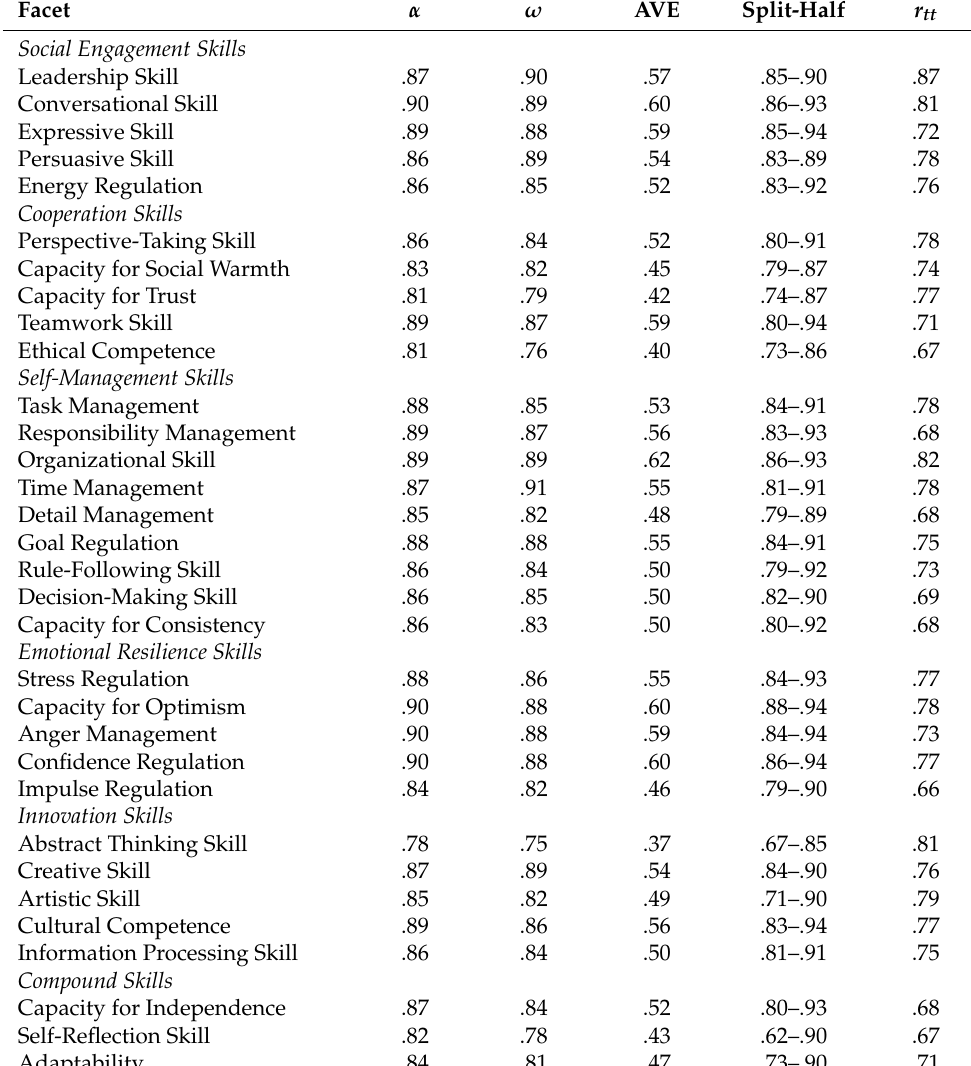
Table A2. Reliabilities of the 32 facets of BESSI-G v0.1 with 1.5 months test–retest reliabilities (Study